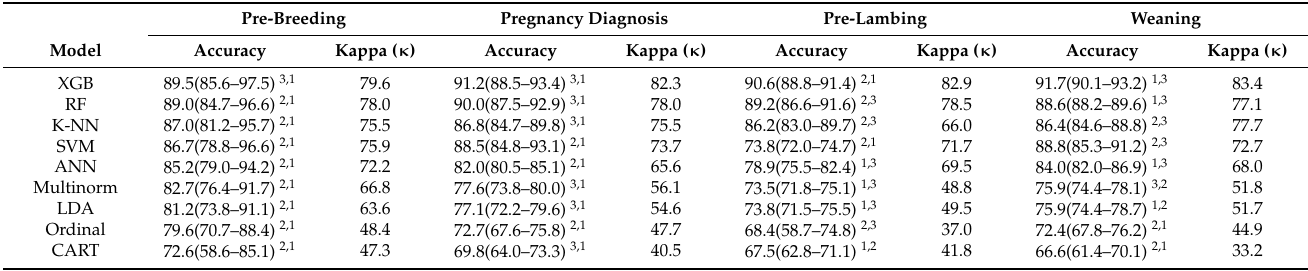
Table 2. Accuracy and kappa statistics of nine predictive models for ewe BCS at 43–54 months of age at different stages of the annual cycle. Values in parenthesis denote the minimum and maximum accuracy, in ascending order.